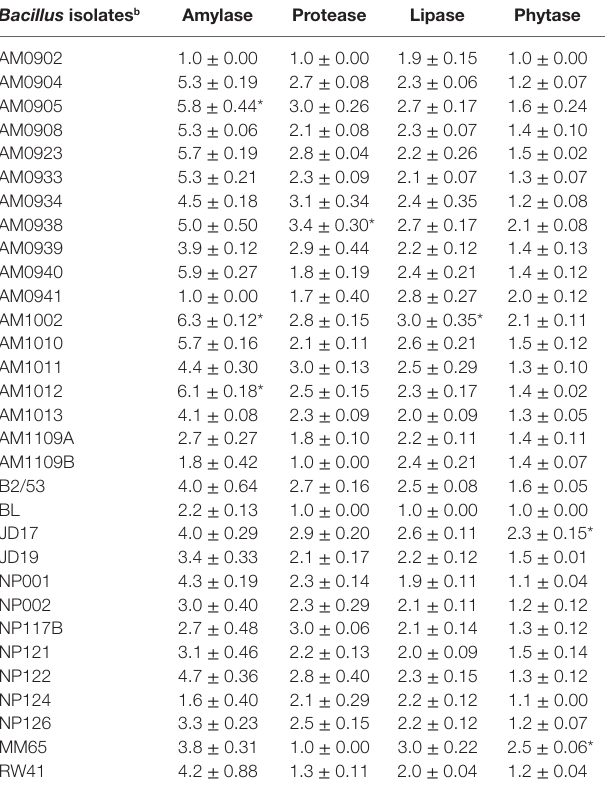
TaBle 1 | relative enzyme activity (rea) a values produced by Bacillus spp. strains evaluated as enzyme producer